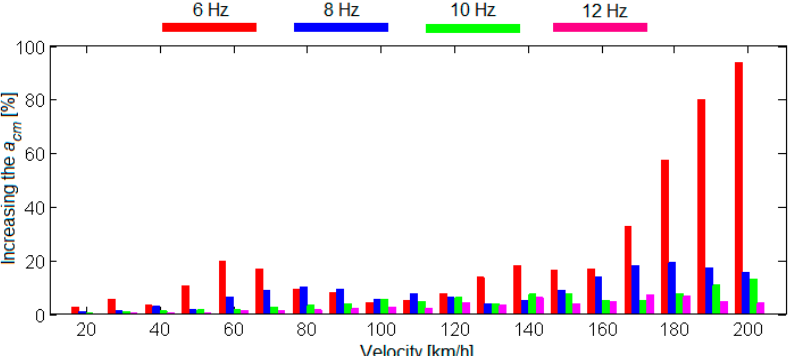
Figure 4. Influence of the carbody vertical bending upon the root mean square of acceleration in correlation with the velocity: ( a ) at the carbody centre; ( b ) against the front bogie; ( c ) against the rear bogie.